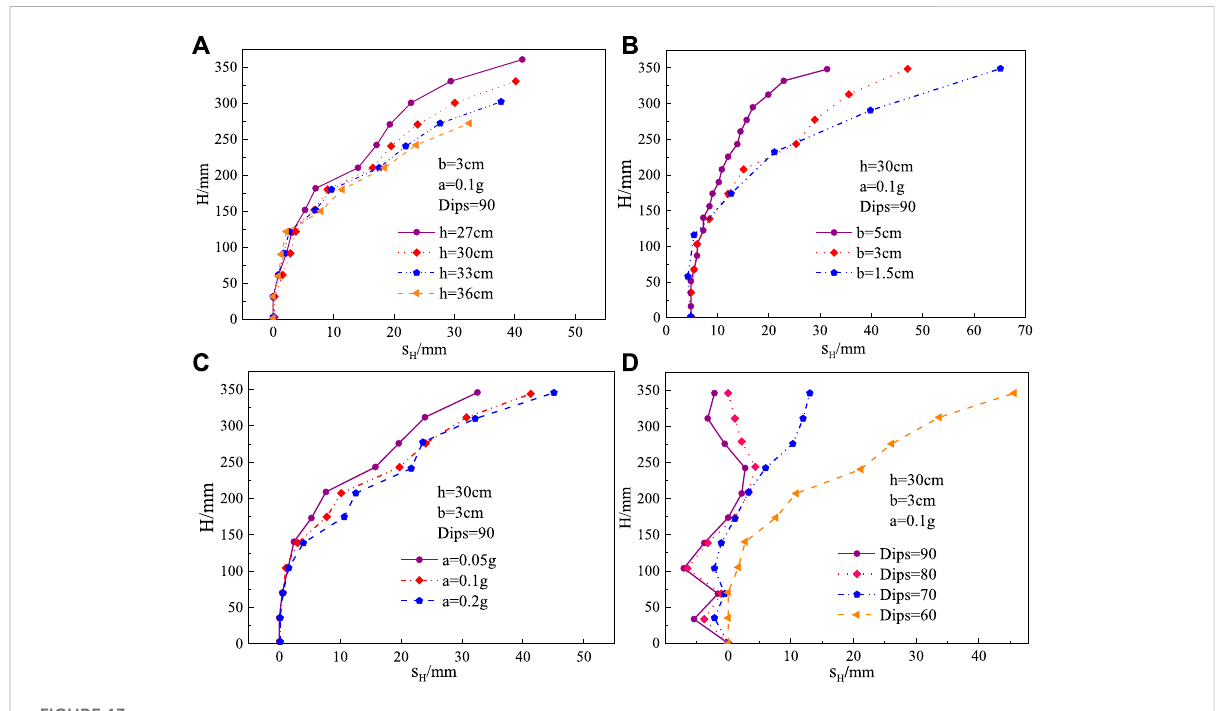
FIGURE 13 Displacement forms at critical failure state. (A) Different stacking heights. (B) Different block sizes. (C) Different seismic accelerations. (D) Different joint